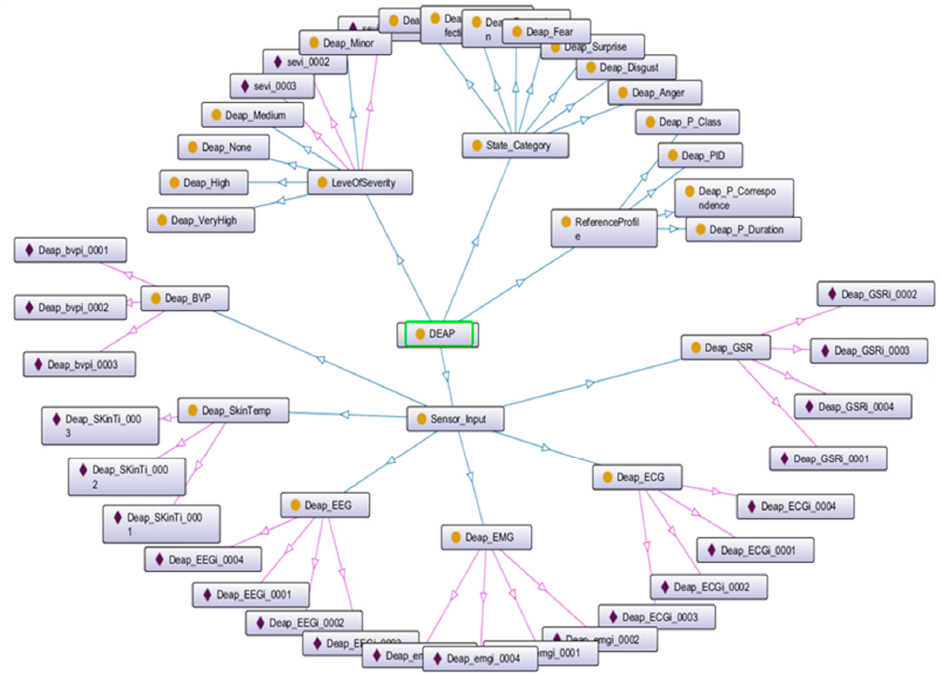
Figure 15. DEAP Semantic Ontology Model.